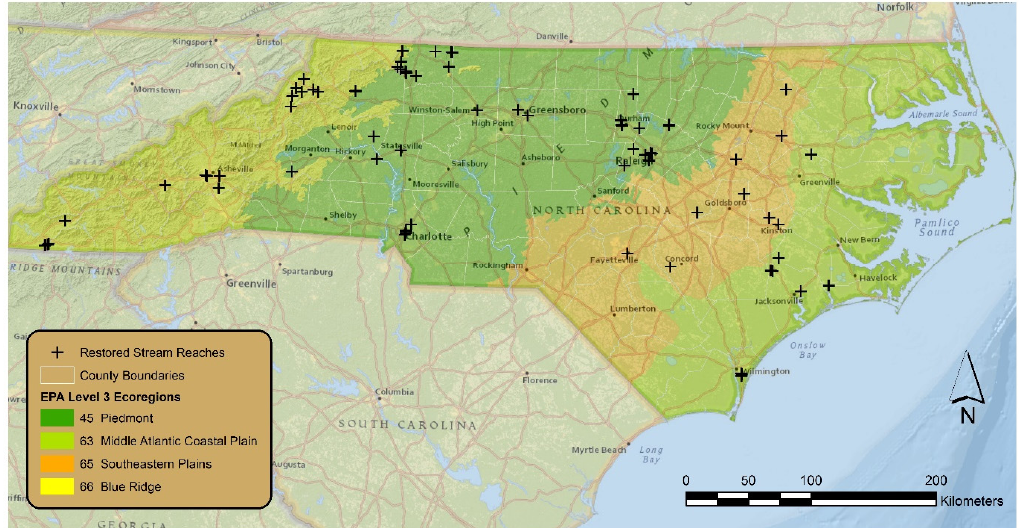
Figure 1. Location of restored streams with design and morphology data.